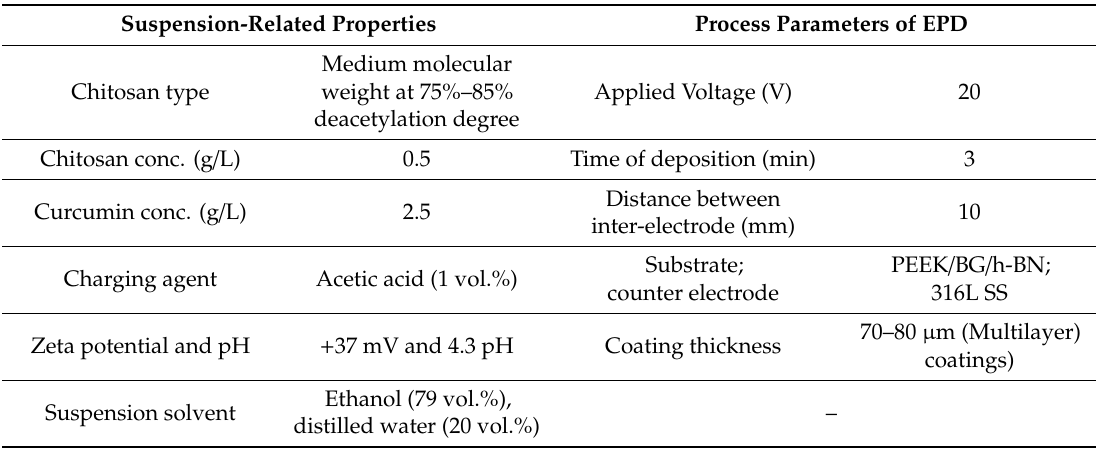
Table 1. Electrophoretic deposition (EPD) parameters along with suspension-related processing characteristics of chitosan / curcumin coatings on the poly-ether-ether-ketone / bioactive glass / hexagonal boron nitride (PEEK / BG / h-BN)